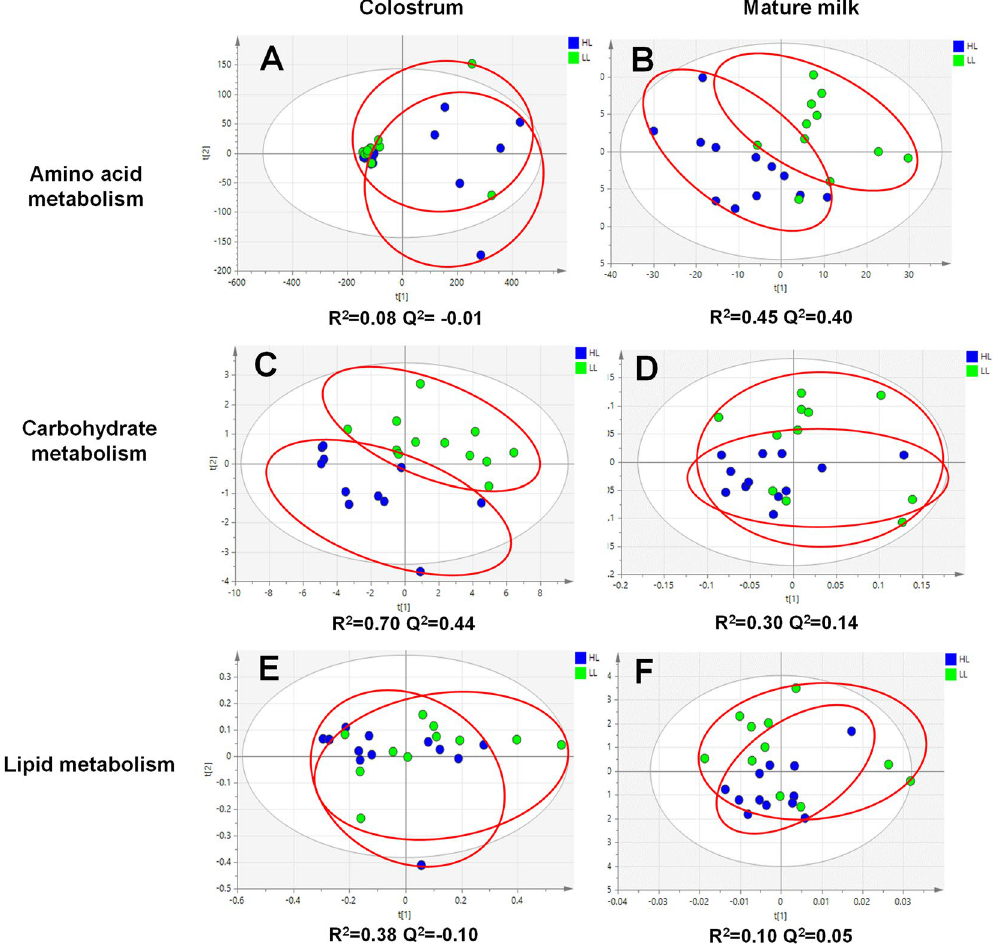
Figure 2. Score plot of PLS-DA model of amino acid, carbohydrate, and lipid metabolism in colostrum and mature milk. HL and LL group are shown in blue or bright green,